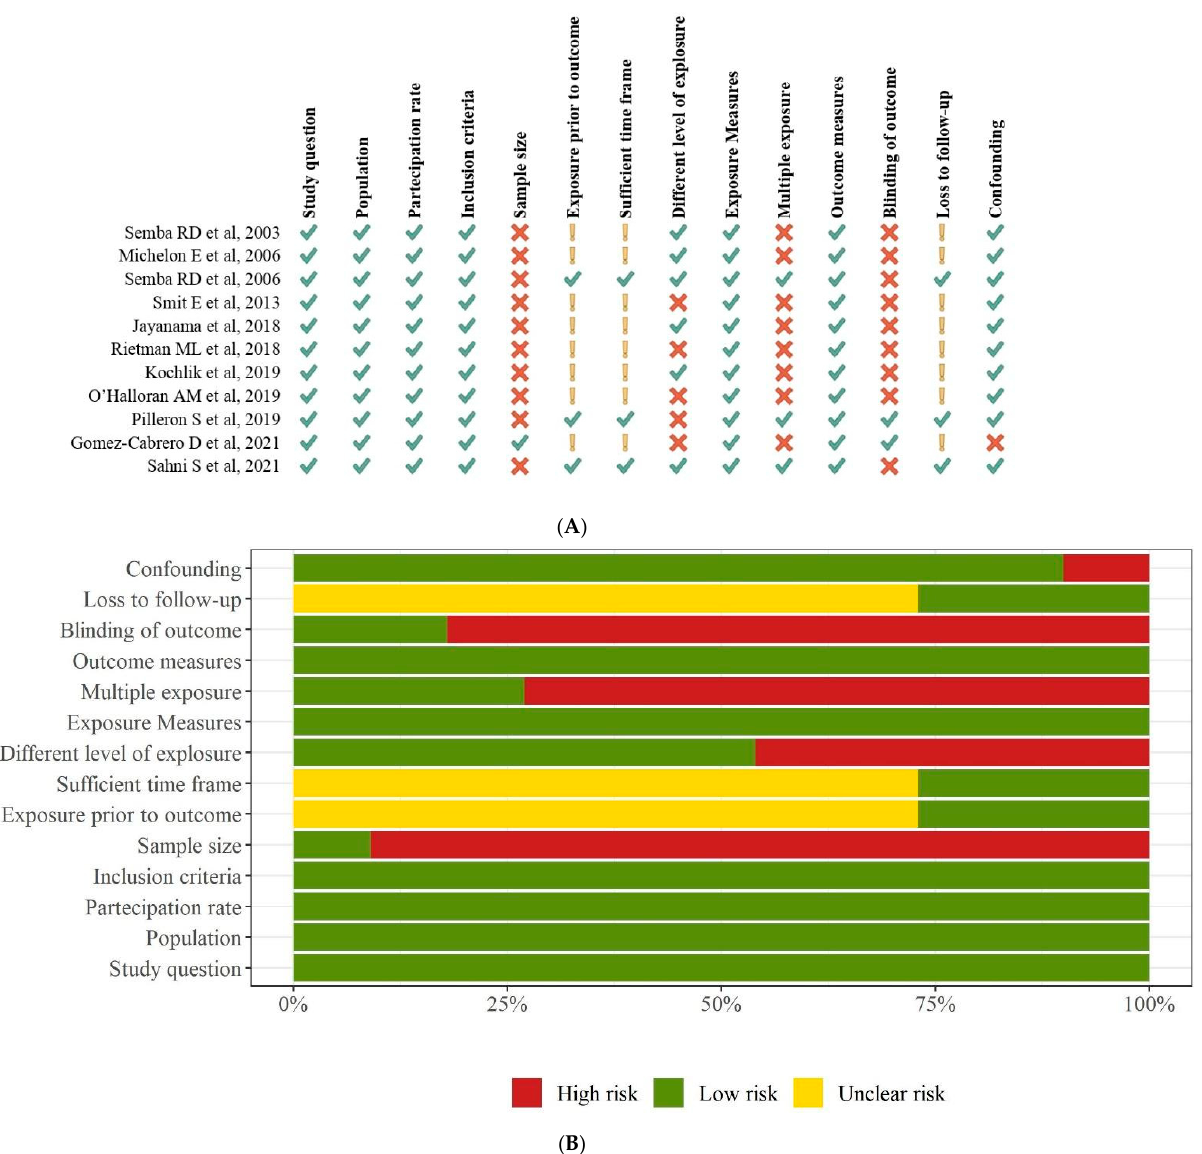
Figure 3. Quality assessment findings using the National Institutes of Health Quality Assessment Toolkits for Observational Cohort and Cross-Sectional Studies. Panel ( A ). Summary of risk of bias. Panel ( B ). Risk of bias graph.